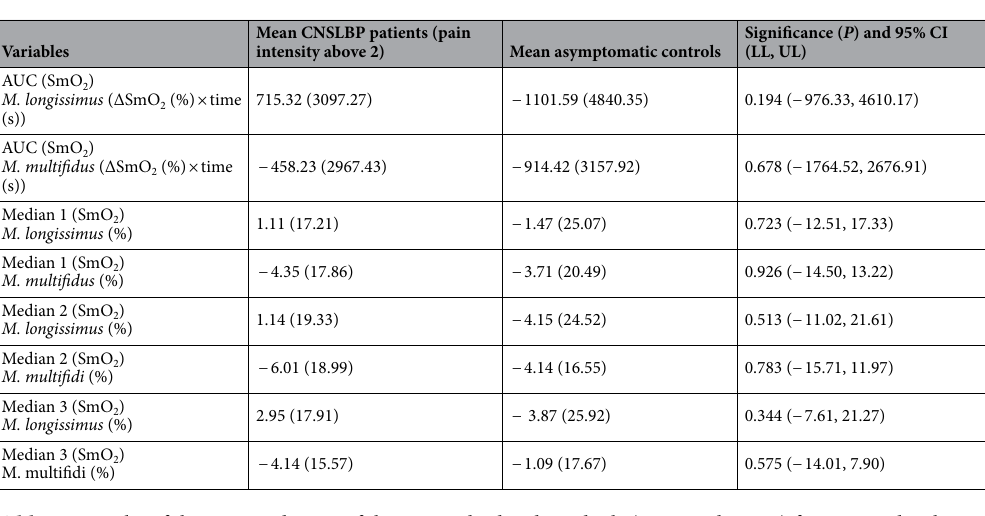
Table 4. Results of the unpaired t-test of the unstandardized residuals (corrected SmO 2 ) for area under the curve (AUC) and medians of oxygenation of the M. longissimus and M. multifidus in chronic nonspecific low back pain subjects (CNSLBP) with pain ratings above 2 and asymptomatic controls. Displayed are the mean, significance ( P ) and 95% confidence intervals, lower limit (LL) and upper limit (UL).